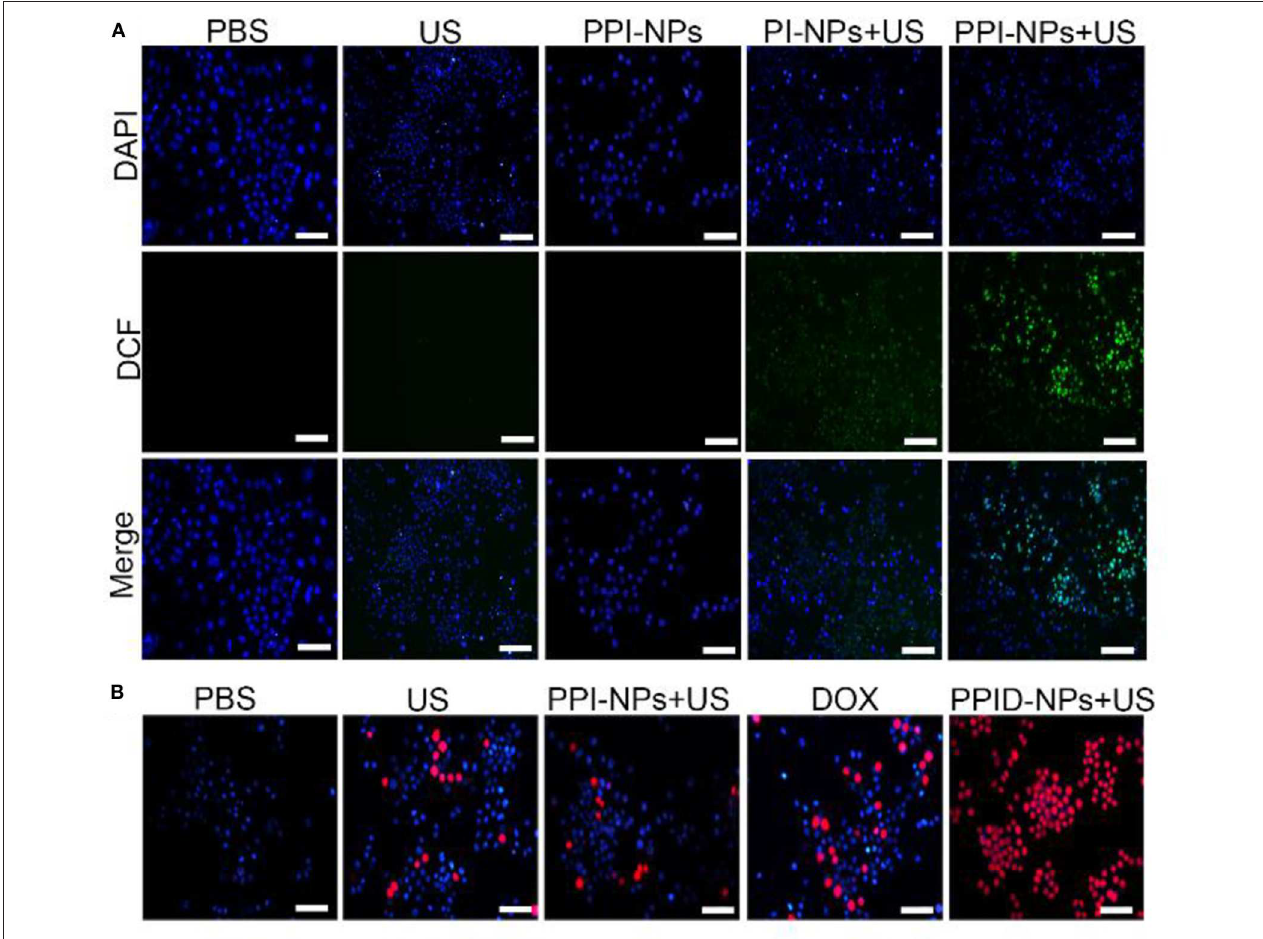
FIGURE 5 | (A) Fluorescence microscope images of DCFH-DA stained 4T1 cells subjected to various treatments (scale bar, 100 µ m). (B) Fluorescence microscope images of DAPI and PI costained 4T1 cells after various treatments (scale bar, 100 µ m).